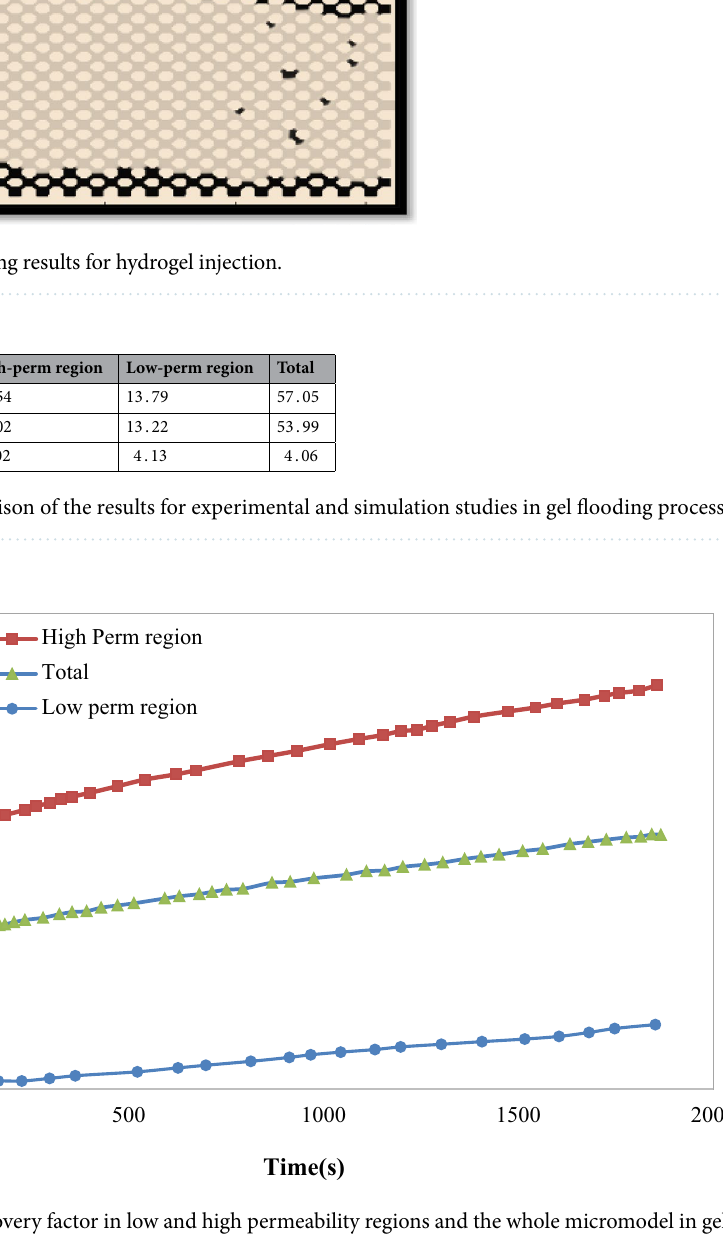
Figure 7. Oil recovery factor in low and high permeability regions and the whole micromodel in gel